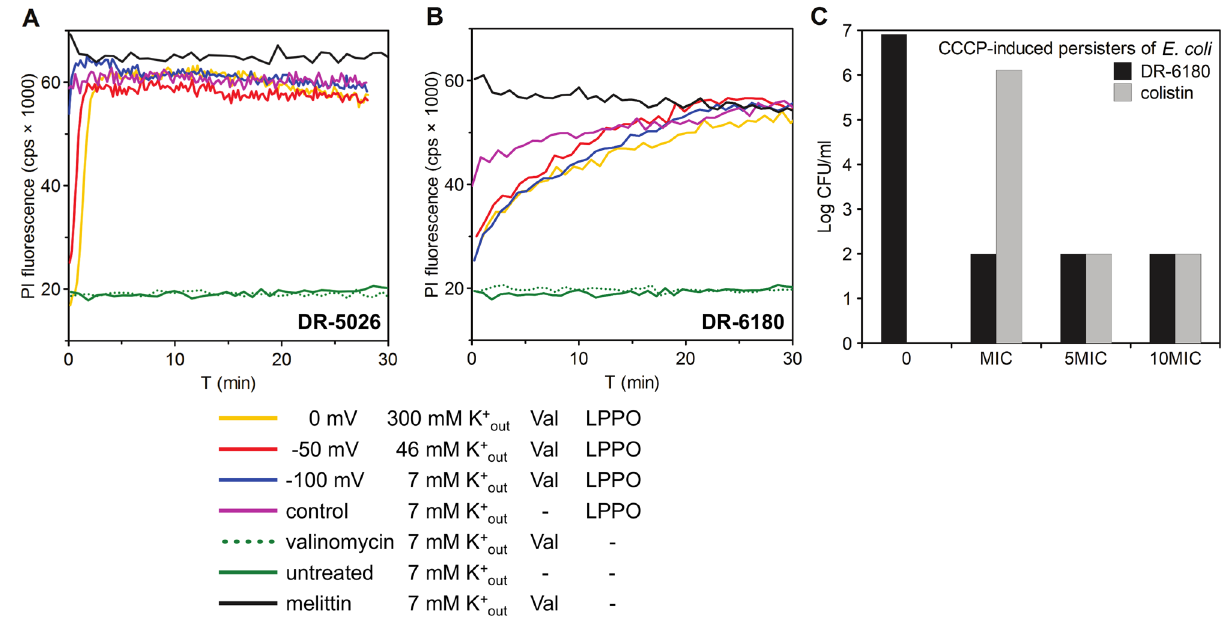
Figure 5. Effect of membrane potential of target cells on LPPO-induced permeabilization. ( A , B ) Membrane permeabilization induced by ( A ) LPPO I (DR-5026) and ( B ) LPPO II (DR-6180) at the concentration of 5 µg/ ml was measured in B. subtilis via the entry of propidium iodide. The cells were resuspended in buffers with different K + out concentrations (indicated in the graph legend) and the membrane potential was adjusted to the desired value of ΔΨ (in millivolts) by the addition of 4 µM valinomycin (for details, see “Materials and methods”). Untreated and valinomycin (Val) control kinetics for a buffer with a 7 mM K + out concentration are shown. Representative results from three independent experiments performed in duplicate are shown. None of the values of adjusted membrane potential affected the activity of the positive control of melittin (10 µM). For clarity, only the kinetics for ΔΨ − 100 mV (7 mM K + out buffer with 4 µM valinomycin) are presented. ( C ) Activity of LPPO II DR-6180 and colistin against CCCP-induced persisters of E. coli . Antimicrobial activity was evaluated by CFU/ml counting after three hours of incubation of persisters with the tested compound at